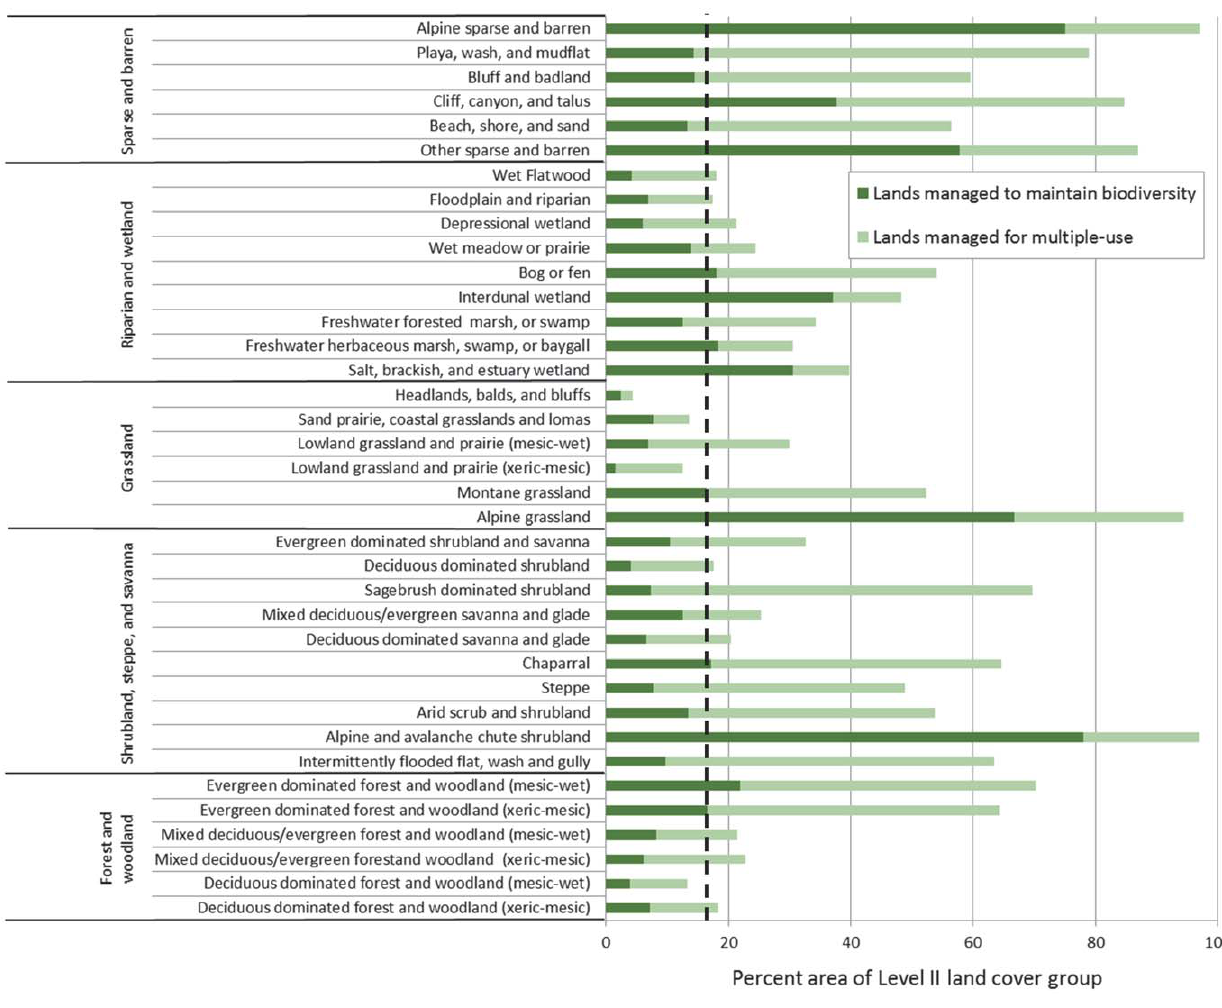
Figure 3. Percent area of Level II land cover groups by protection status. The Level II land cover groups are arranged by Level I land cover groups (see Table S1) [23]. Percent area for both lands managed to maintain biodiversity and lands managed for multiple-use are shown [24]. See Table 1 for protection status descriptions. A dashed line representing the 17% Aichi Biodiversity Target of the Convention on Biological Diversity is shown [36].